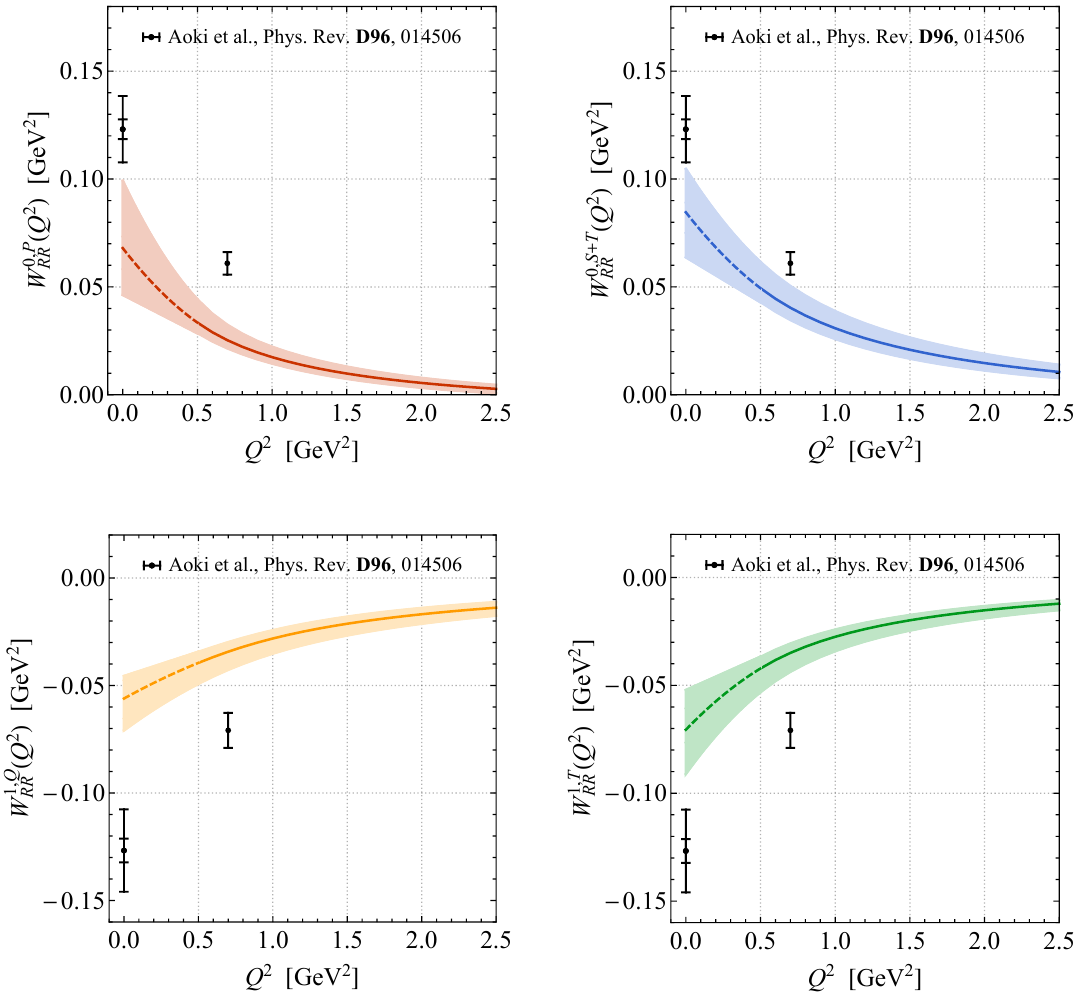
Figure 4 . Form factors W n,α ( Q 2 ) as a function of Q 2 . The coloured curves and bands correspond RR to the central values and uncertainties of the four independent LCSRs (3.17). The predictions for 0 . 5 GeV 2 ≤ Q 2 ≤ 2 . 5 GeV 2 are obtained by a direct calculation (solid lines), while the predictions for Q 2 ≤ 0 . 5 GeV 2 are obtained by an extrapolation (dashed lines). The black dots display the central values of the form factors calculated in LQCD [39]. The associated single (double) error bars represent statistical (total) uncertainties. Consult the main text for further